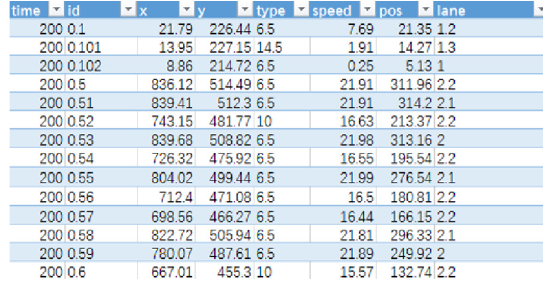
Figure 6 Text information digitalization